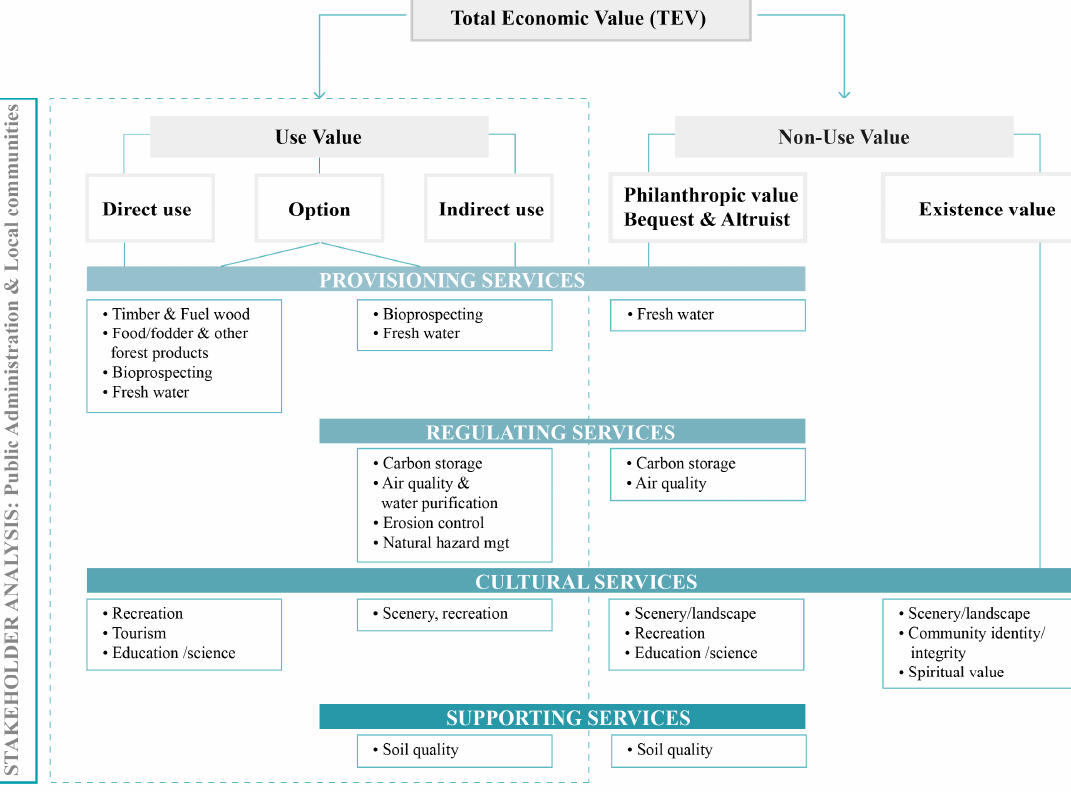
Figure 1. Integration of Total Economic Value with ES under a social perspective. Adapted from Pearce 1992.